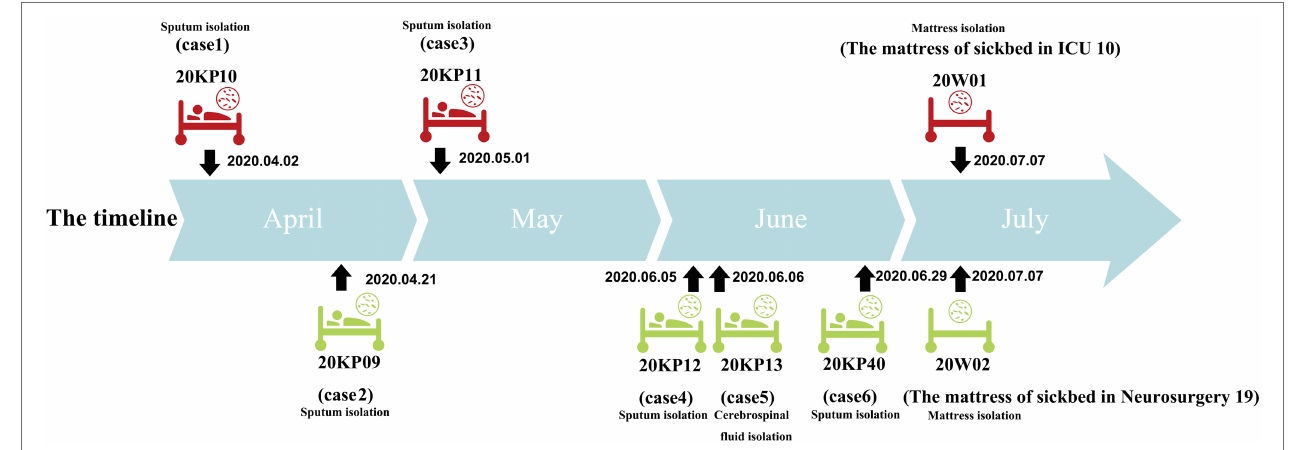
FIGURE 1 | Timeline of isolation of the eight drug-resistant Klebsiella pneumoniae (XDRKp) strains in this outbreak. The red pattern represents isolation from the ICU, and the green pattern represents isolation from the neurosurgery unit. The date next to the black arrow are the isolation date of the